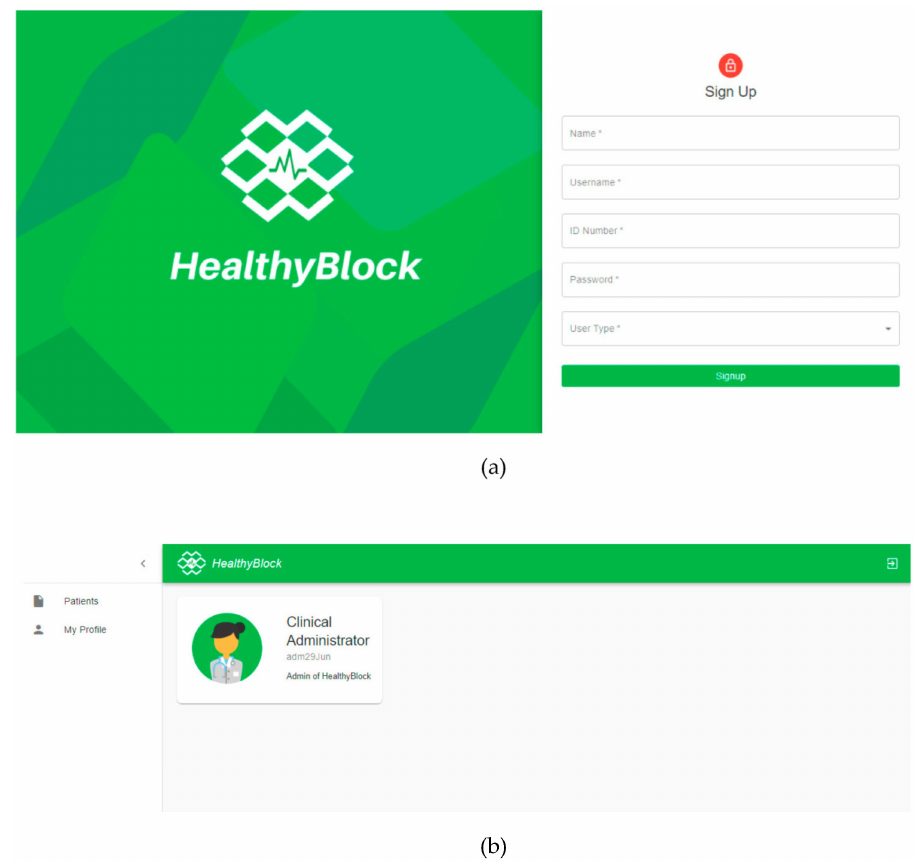
Figure A1. Prototype user processes: ( a ) access interface; ( b ) manager